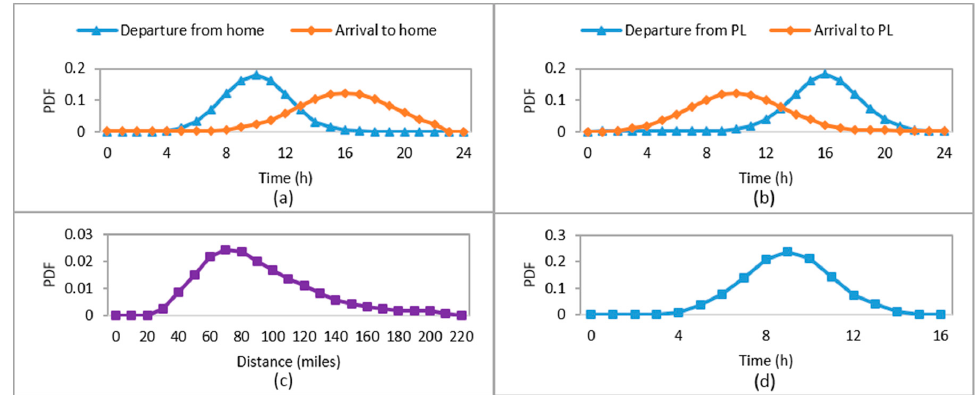
Figure 3. Probability distribution functions of arrival and departure time, distance and stay duration: ( a ) PDF of normal distribution for departure and arrival time from/to home; ( b ) PDF of normal distribution for departure and arrival time from/to PL; ( c ) PDF of normal distribution for distance traveled; ( d ) PDF of normal distribution for parking duration.